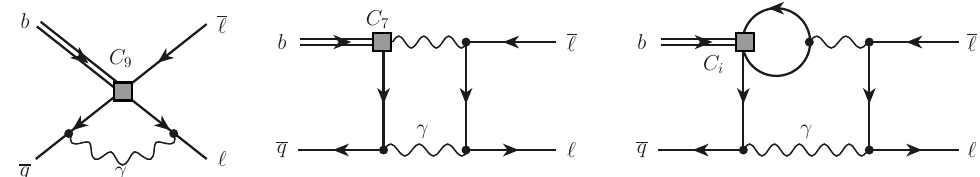
Figure 2. Feynman diagrams that contain the power-enhanced electromagnetic correction. Sym- metric diagrams with order of vertices on the leptonic line interchanged are not